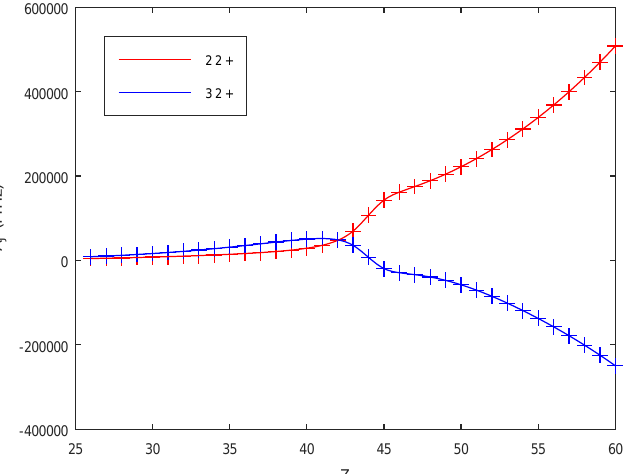
Figure 8. Plot of the hyperfine interaction constants A J for the two interfering even parity states with J = 2 as function of the nuclear charge Z . The M-file was edited, and we added the legend, see Section